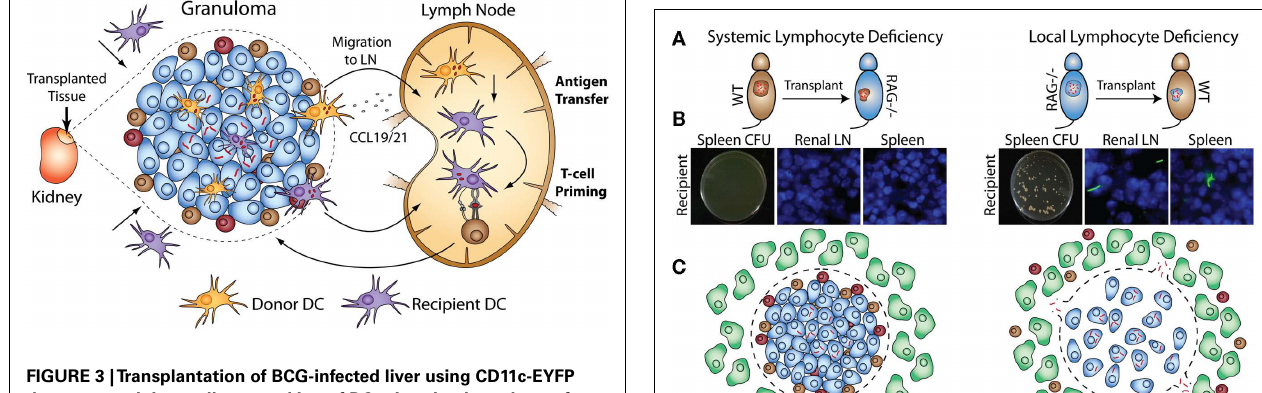
FIGURE 3 |Transplantation of BCG-infected liver using CD11c-EYFP donors or recipients allows tracking of DC migration in and out of acute and chronic granulomas. After transplantation, donor DCs migrate out of granulomas, and recipient DCs also migrate in.The ability of DCs to prime systemic immune responses after surveying granulomas can be measured when coupled with adoptive transfer of antigen-specificT-cells into transplant recipients. SystemicT-cell priming after transplantation of acute granulomas results from CCR7-dependent migration to the lymph nodes of donor DCs that have BCG antigen.The antigen is transferred to recipient DCs and presented to mycobacterial-specific, transferredT-cells. Priming after transplantation of both acute and chronic granulomas was absolutely dependent on recipient MHC II.